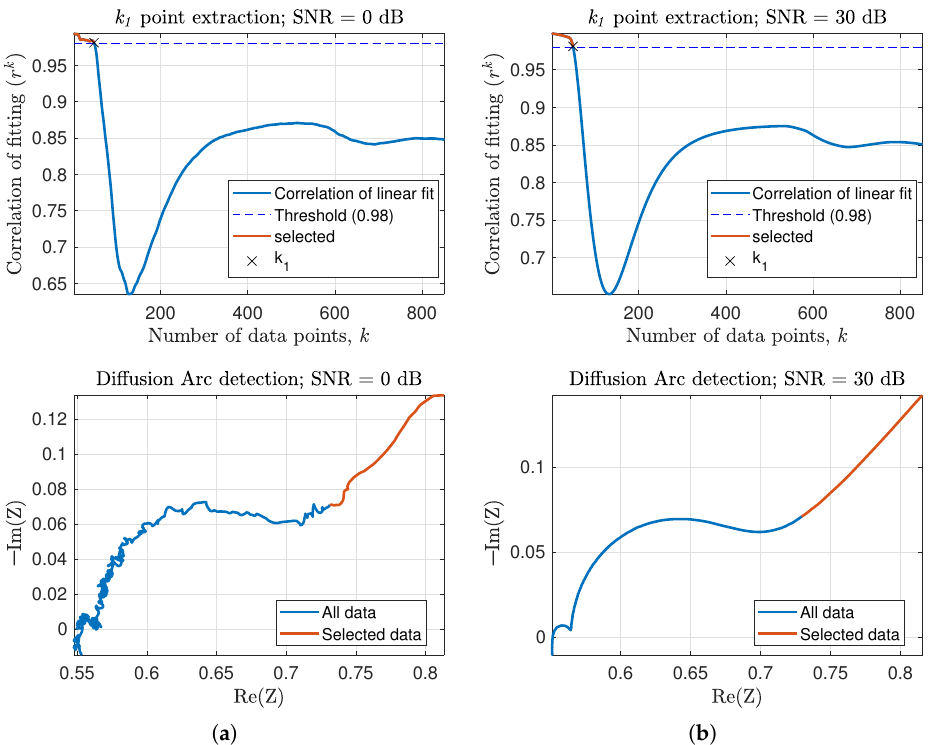
Figure 4. Diffusion-arc detection. The top plots show the correlation of fitting (77) along with the threshold. The plots at the bottom show the detected Diffusion Arc in red. ( a ) Low SNR. ( b ) High